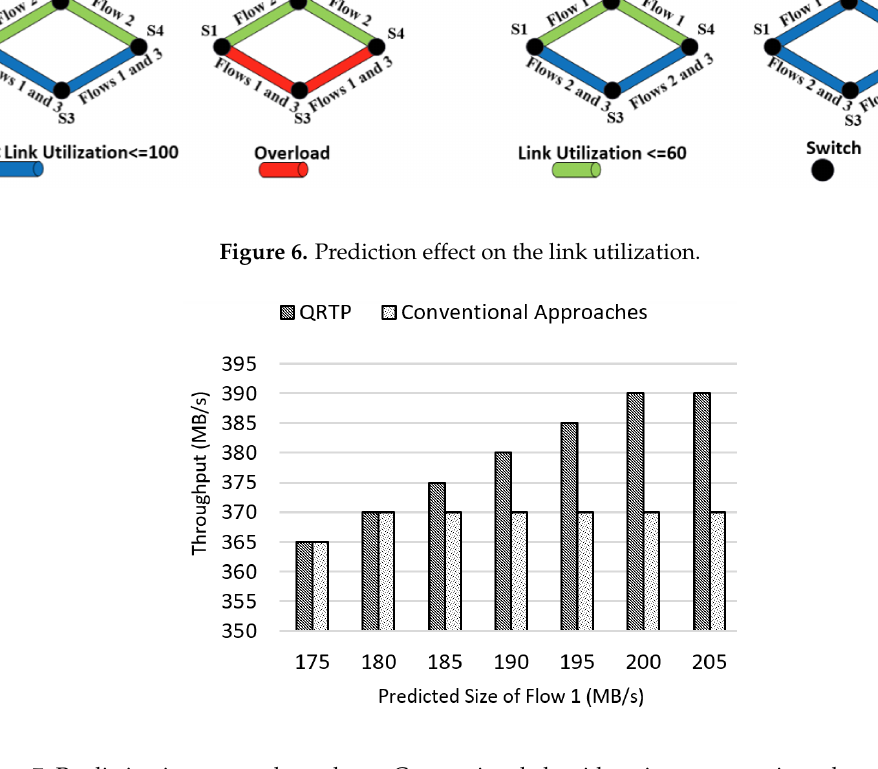
Figure 7. Prediction impact on throughput. Conventional algorithms incur congestion when there